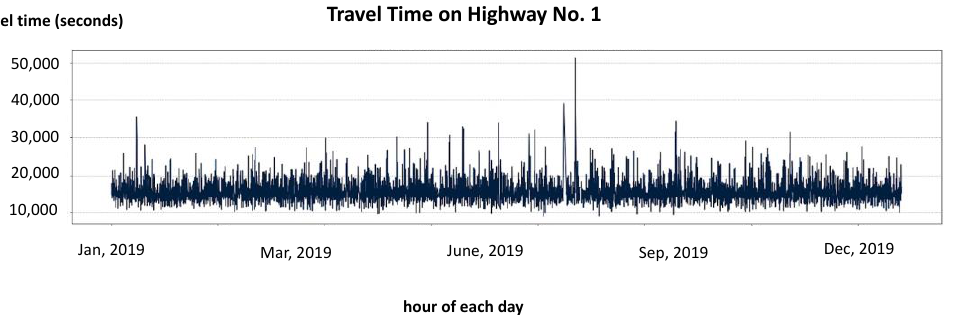
Figure 4. Line chart of the average hourly travel times from Table 1, where the x -axis shows intervals of hours in chronological order, and the y -axis is average travel times of each hour in seconds. Table 2. Summary of the data of trips passing through the 10 selected road segments.